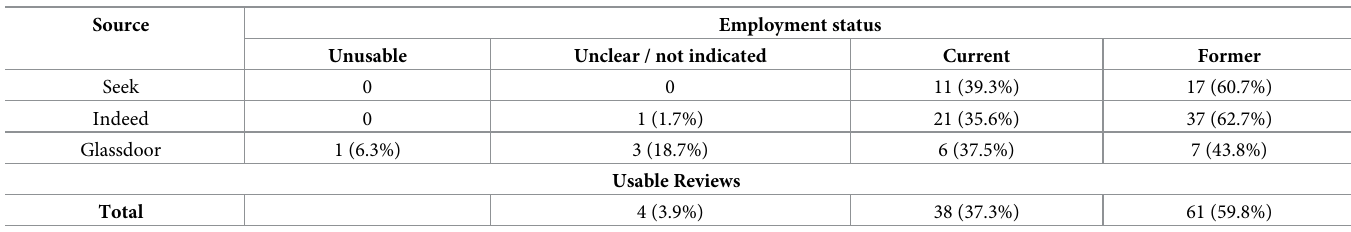
Table 3. Reviews across sites by number of current and former employees.